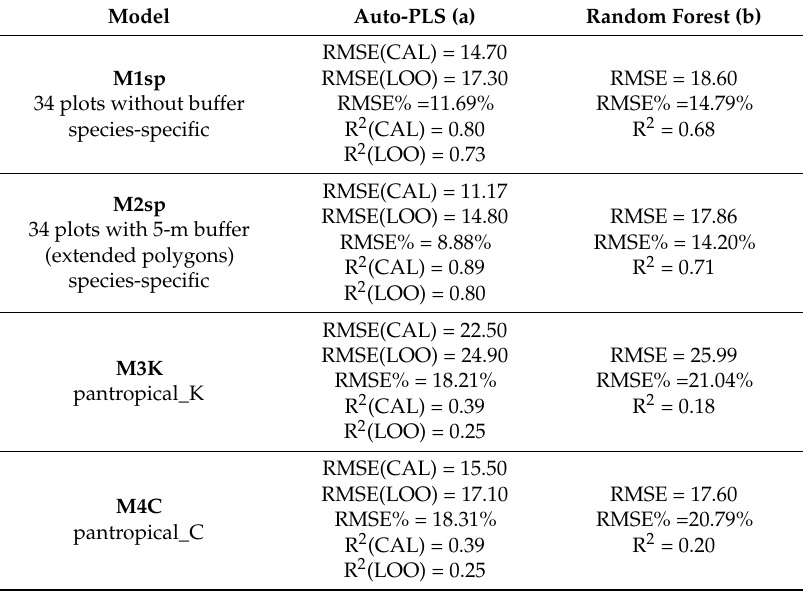
Figure 7. Mangrove aboveground biomass map (AGB in t · ha − 1 ) of APA Guapimirim and ESEC Guanabara obtained using the best regression model, M2sp.autopls (Auto-PLS). Non-mangrove areas appear in black. The black lines delimit the APA Guapimirim (outside) and the ESEC Guanabara (inside). (EPSG Projection: 32723). Table 5. Results of the regression models tested for predicting biomass. Model 1 species-specific (M4C) using 34 plots for ( a ) Auto-PLS and ( b ) random forest. (Calibration (CAL),